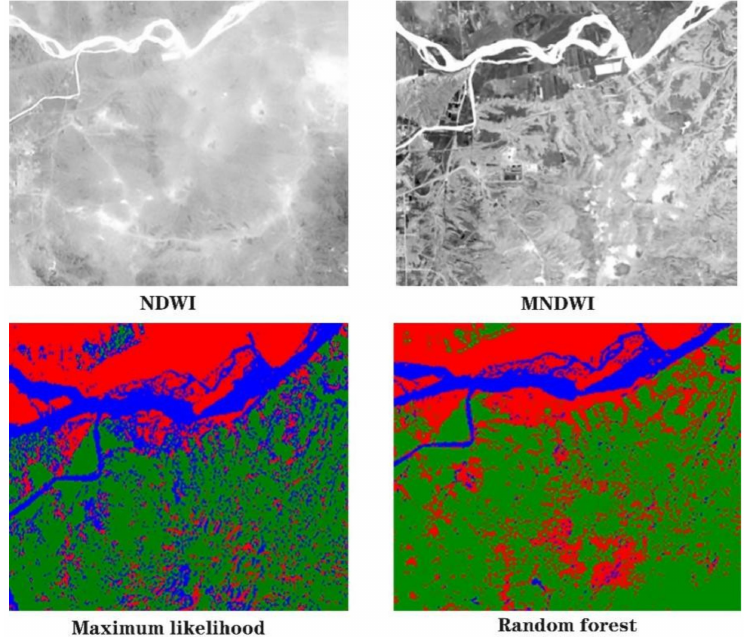
Figure 13. Edge extraction of the southern bank of the Yellow River from Landsat images. Data obtained from the extraction of the edge of the Yellow River from images of different periods were vectorized and aligned in ArcMap 10.6 to obtain the shortest distance between the SHS site from 1960 to 2020 and the Yellow River (Figure 14). The path of the Yellow River is complex in this section of the SHS site [89]. The distance between the Yellow River and the SHS site fluctuated according to the river path over the last 60 years, with the overall trend being characterised by a greater distance from the site. The Yellow River was farthest from the SHS site in approximately 2004, with a distance of approximately 2675 m. The Yellow River was closest to the SHS site in approximately 1970, with a distance of approximately 512 m. Although it is impossible to infer the distance between the Yellow River and the SHS site during the Yangshao period, it is reasonable to postulate that the Yellow River was once very close to the site. Access to water sources and terrain were quite important factors influencing the locations and survival of early settlements